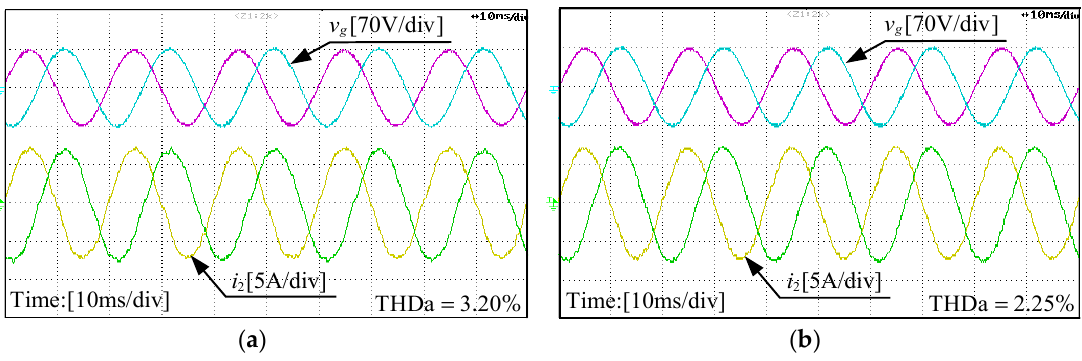
Figure 12. The experimental performance comparison results between ( a ) the proposed control method and ( b ) the FCS-MPC with full status measurements.